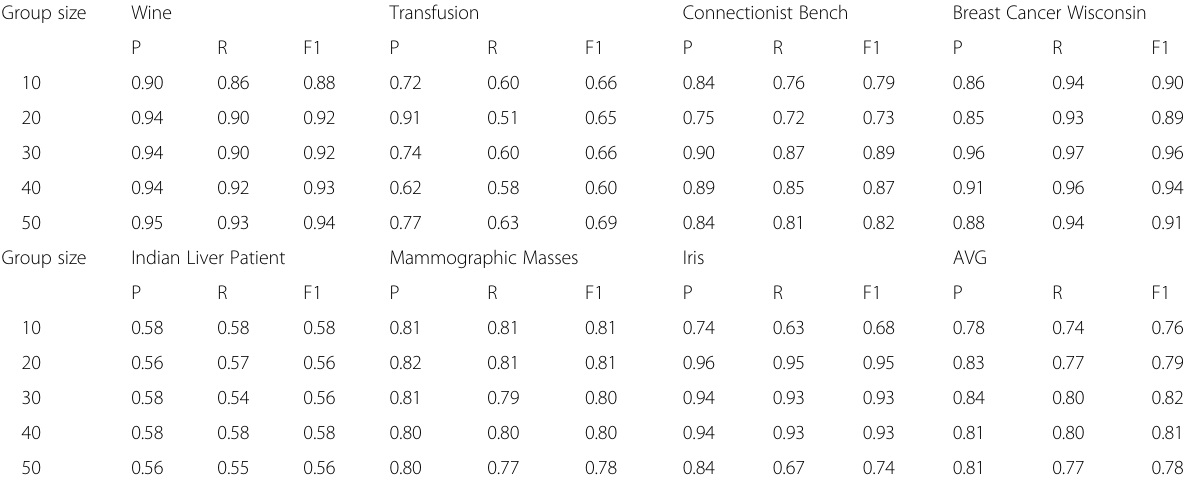
Table 8 The influence of the horizontal grouping of UCI dataset in the GVCA method on classification performance Group size Wine Transfusion